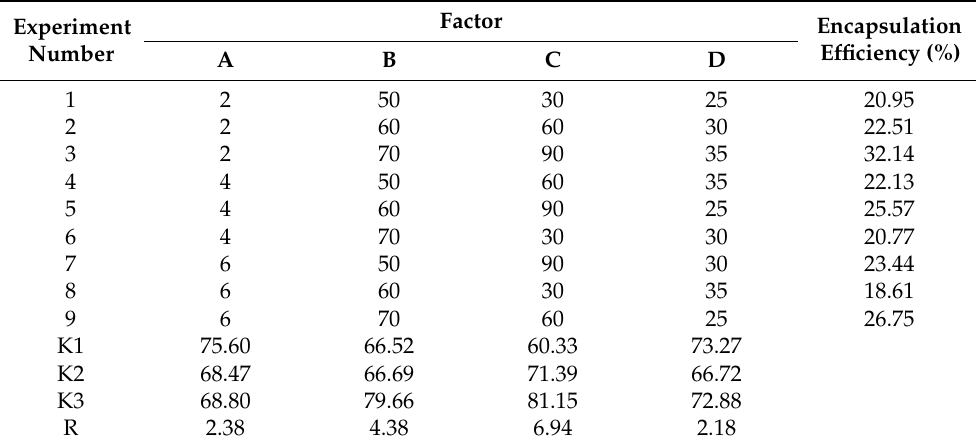
Table 3. Orthogonal experiment design and results concerning encapsulation efficiency.